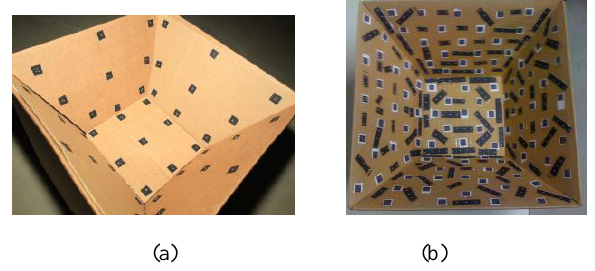
Figure 4(a). A rigid box design for calibration of small format cameras and (b) another design with an increased number of targets